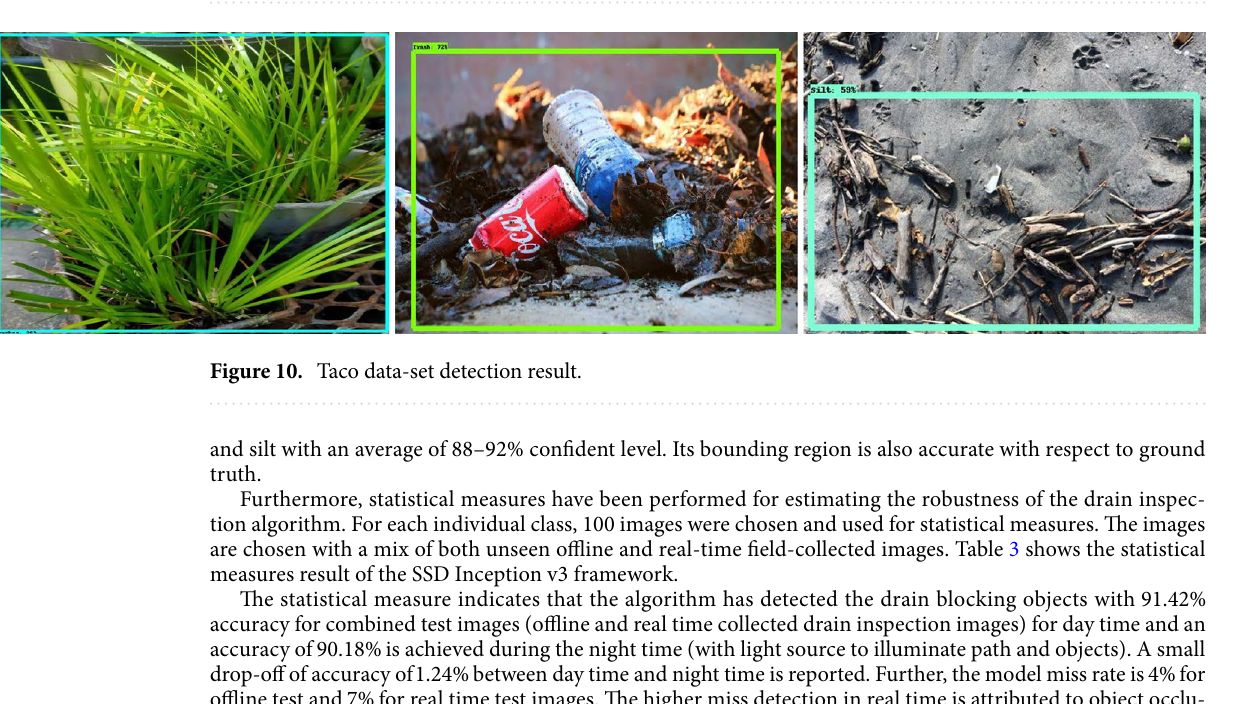
Figure 9. Offline test-web collected images trash, bushes and silt detection.